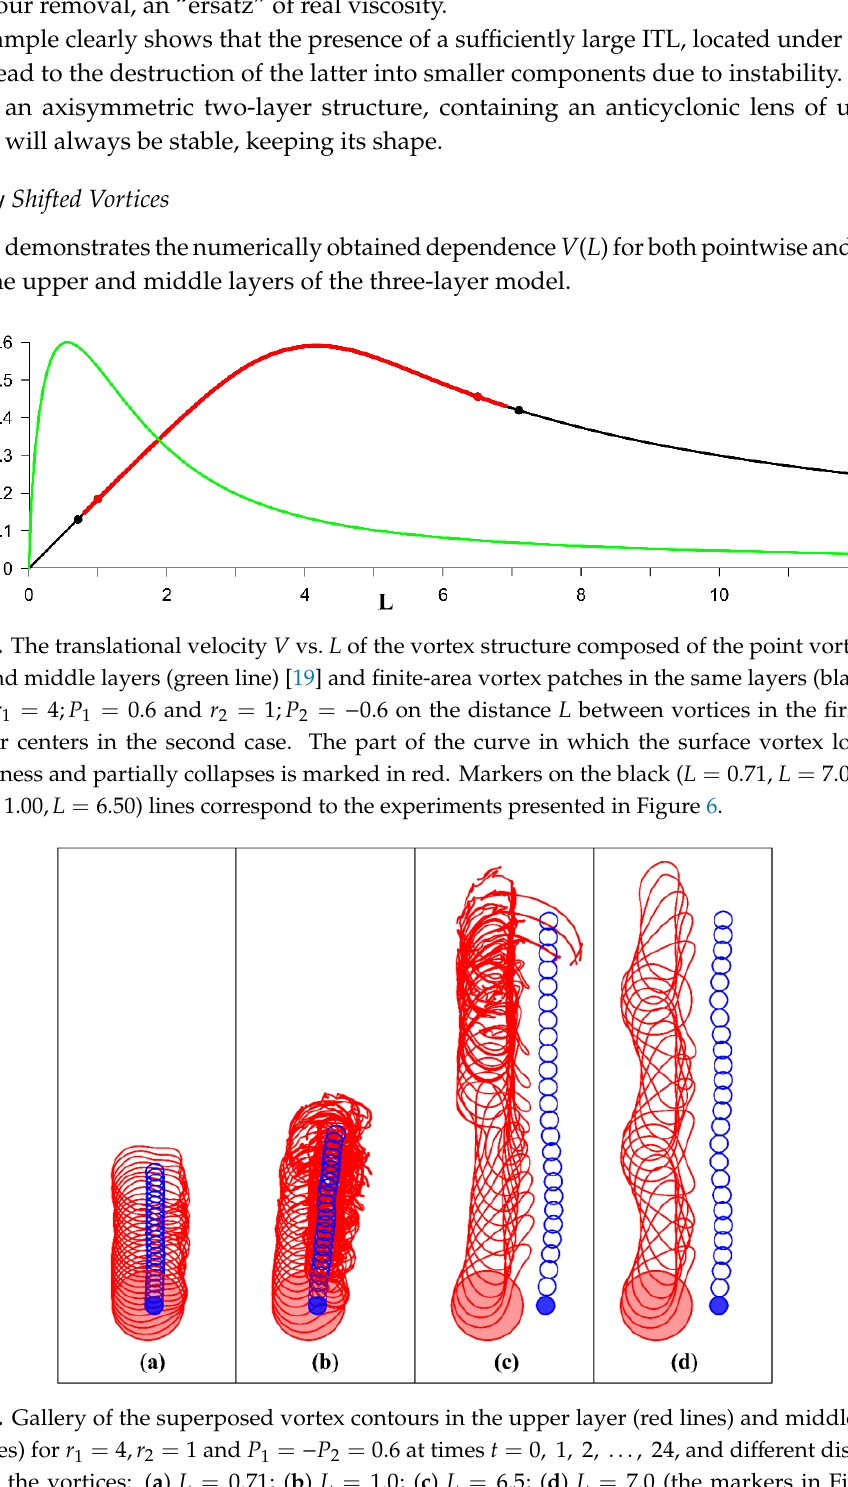
Figure 4. Horizontal projections of the synchronous configurations of the vortex-patch contours of the upper (red) and middle (blue) layers at the dimensionless moments indicated on each subplot, for (𝑟 1 ; 𝛱 1 ) = (4;0.25) and (𝑟 2 ; 𝛱 2 ) = (3; −0.60) , i.e., a ratio of “effective” vorticity, 𝛲 1 𝛲 2 ⁄ = −0.4444. The round marker in the region of instability in Figure 3 corresponds to this experiment.